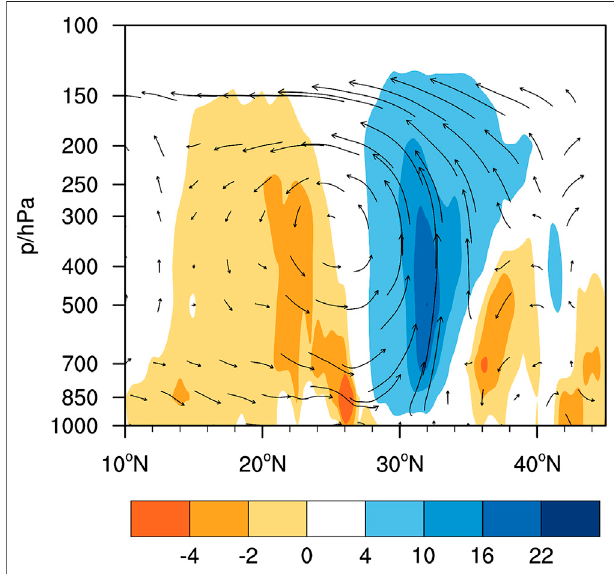
FIGURE 8 | The mean vertical meridional circulation (arrow, unit: m s − 1 ) and vertical velocity (colored, unit: − 10 − 2 Pa s − 1 ) at 110 ° E – 120 ° E during July 11 – 19, 2020.